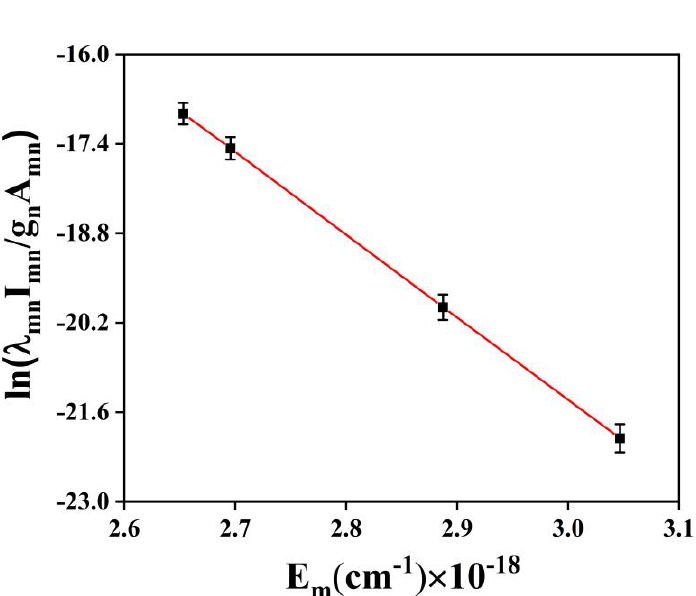
Figure 4. The slope of Boltzmann plot obtained by using spectroscopic data of laser-ablated Cu.